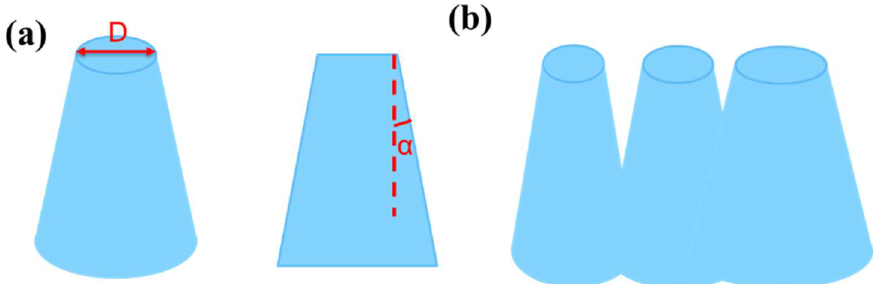
Figure 4. ( a ) Schematic of the model built with the truncated cone to simulate sidewall inclination. ( b ) Adjacent unit structures will overlap when the diameter of the bottom exceeds the unit period length.